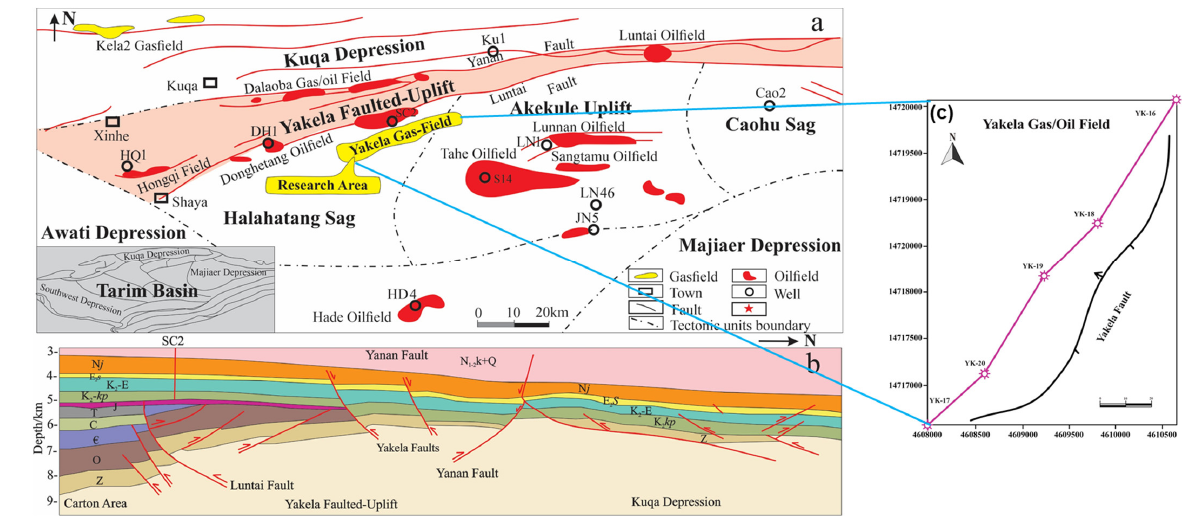
Figure 1. “( a ) Location of the Yakela gas field (research area), Faulted Uplift, and tectonic units of the Tarim Basin ( b ) Yakela Faulted Uplift schematic structural cross section and ( c ) the base map of interpreted wells, modified according to [23].